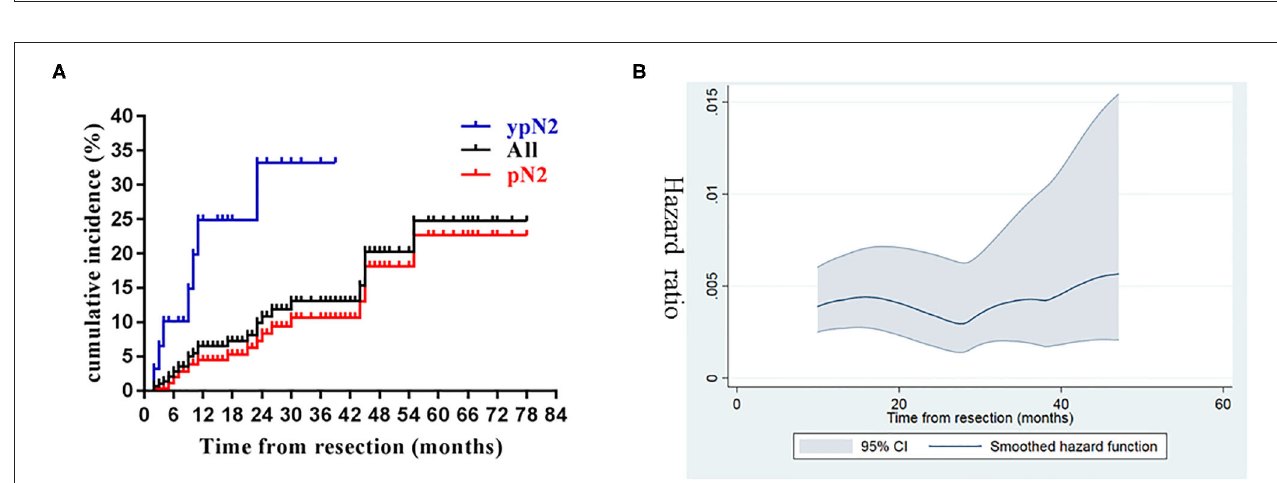
FIGURE 2 | Cumulative incidence and dynamics of supraclavicular recurrence. (A) Cumulative incidence of supraclavicular recurrence in the entire cohort and stratified by pathological status (ypN2 vs. pN2). (B) The dynamics of hazard ratio of supraclavicular recurrence.